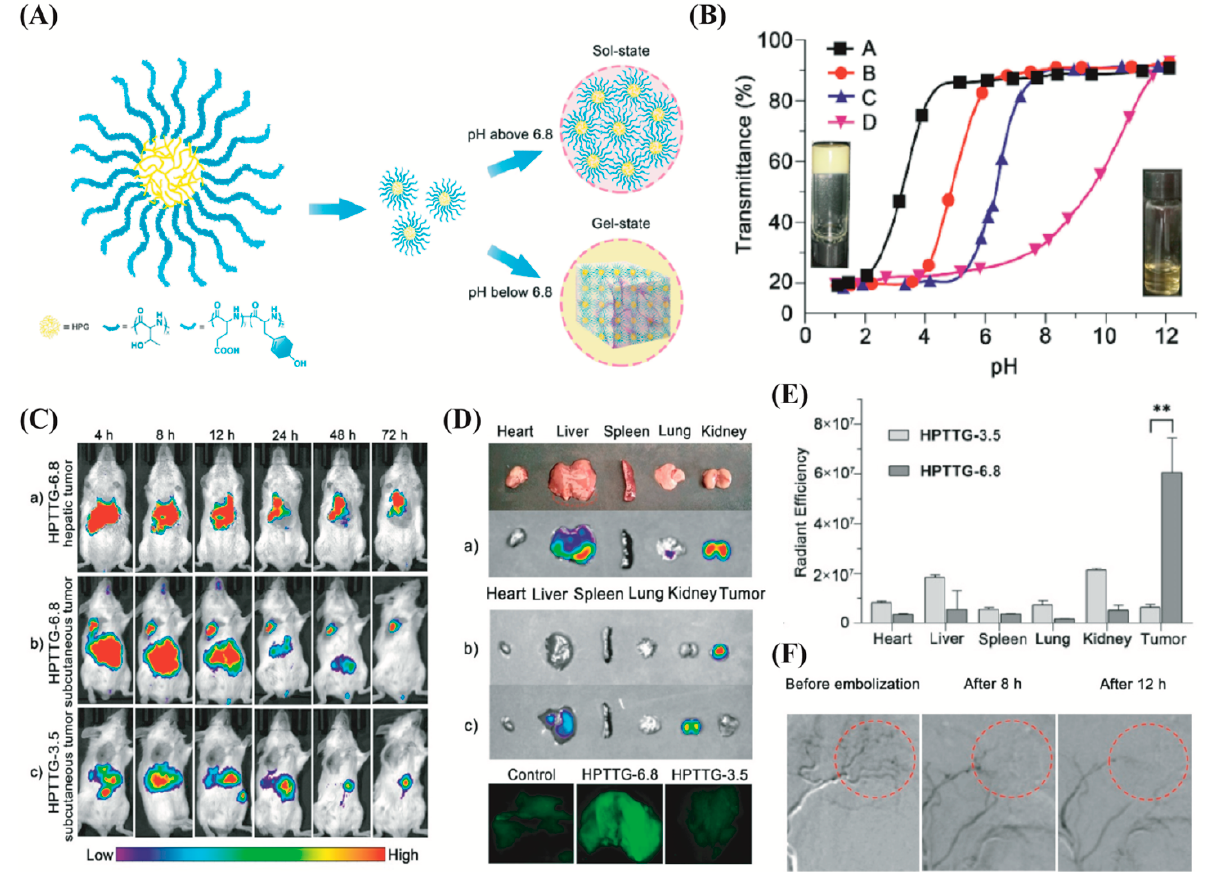
Figure 5. ( A ) Schematic outline of the gelation mechanism of HPTTG. ( B ) Transmittance-pH curve of HPTTG-based copolymers to analyze the sol–gel transition. ( C ) Efficient accumulation in tumors by doing fluorescence imaging at 4, 8, 12, 24, 48, and 72 h after post injection. ( D ) Fluorescence imaging of hepatic tumor and subcutaneous tumor of mouse tissues after 72 h postinjection (a: HPTTG-6.8 (hepatic tumor); b: HPTTG-6.8 (subcutaneous tumor); c: HPTTG-3.5 (subcutaneous tumor)). ( E ) Quantification of two HPTTG microspheres biodistribution in right forelimb tumor model. ( F ) DSA images of the mouse hepatic tumor before embolization, after 8 h, and after 12 h of embolization. **: p < 0.01, statistically difference. Reproduced with permission from Ref. [129].